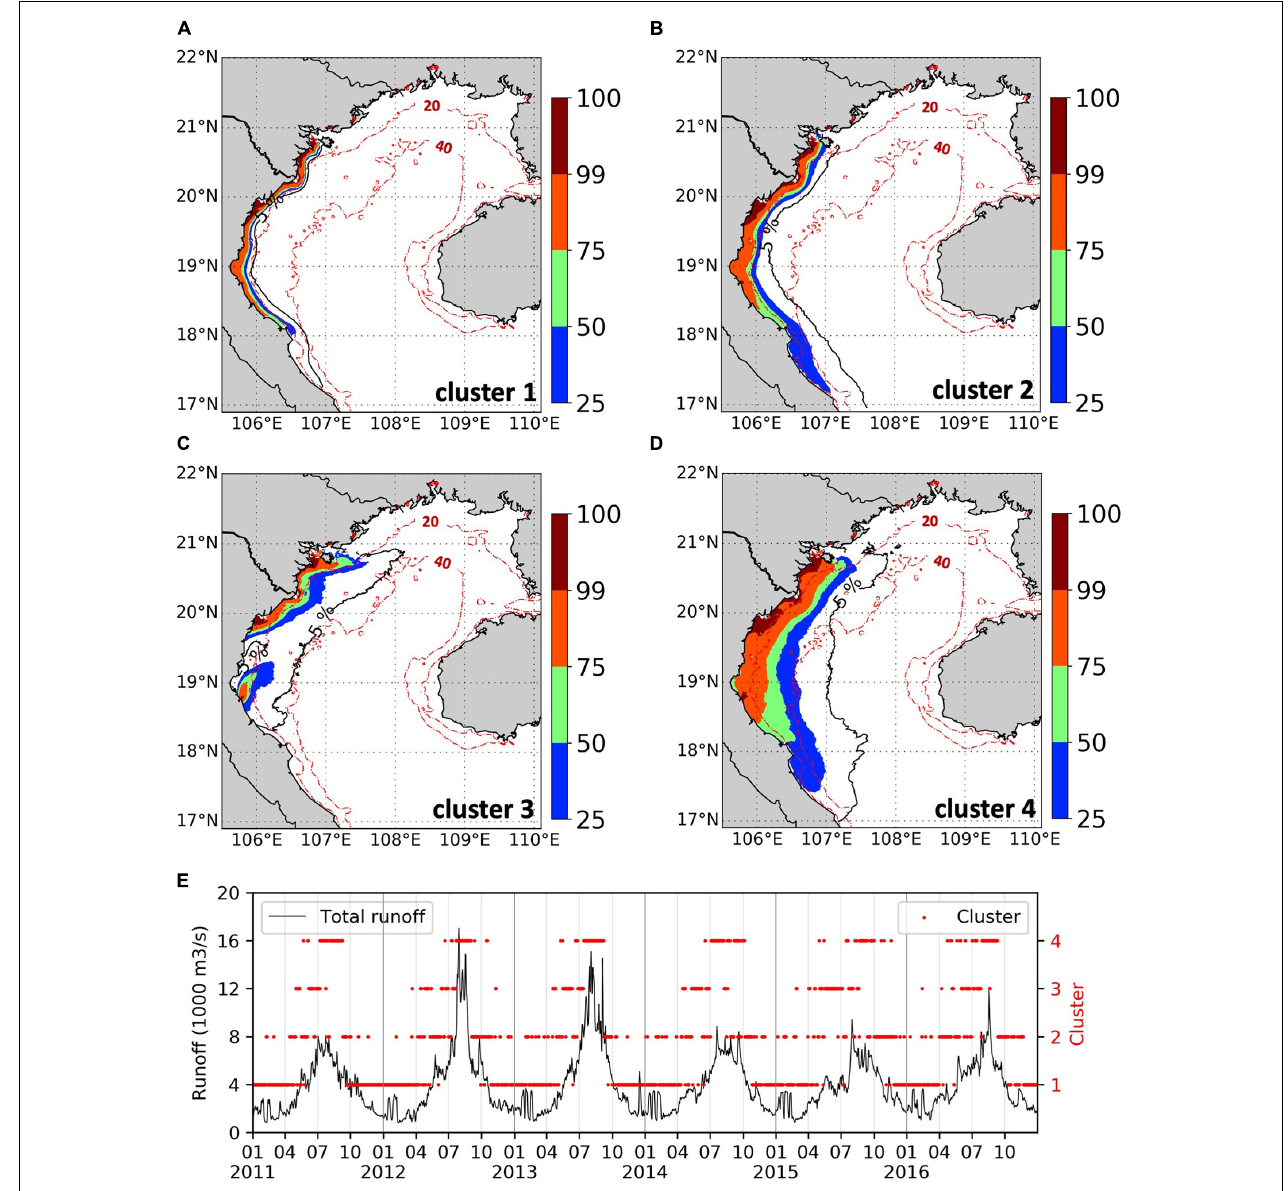
FIGURE 9 | Frequency of occurrence of the plume within cluster 1 (A) , cluster 2 (B) , cluster 3 (C) , cluster 4 (D) . For instance, for cluster 1: at a given point, a frequency of 25 means that over the whole period when cluster 1 is present, the plume is present at this point 25% of the time. (E) Temporal distribution of each cluster (in red) and the runoff from Red and Southern rivers (in